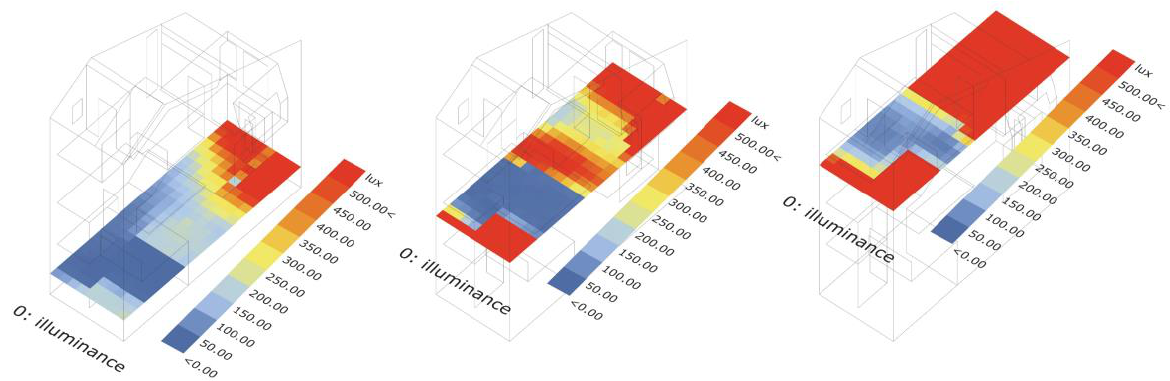
Figure 25. Daylight simulation results for the three main floors visualized with the Ladybug tools (simulated by the students).